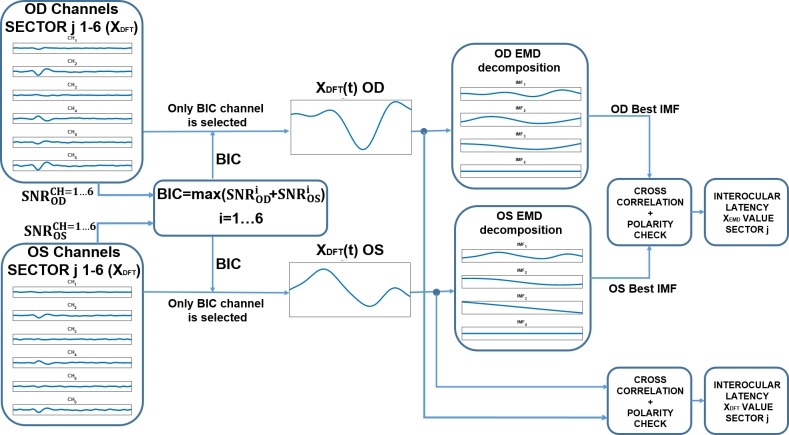
Interocular latency computation flow.